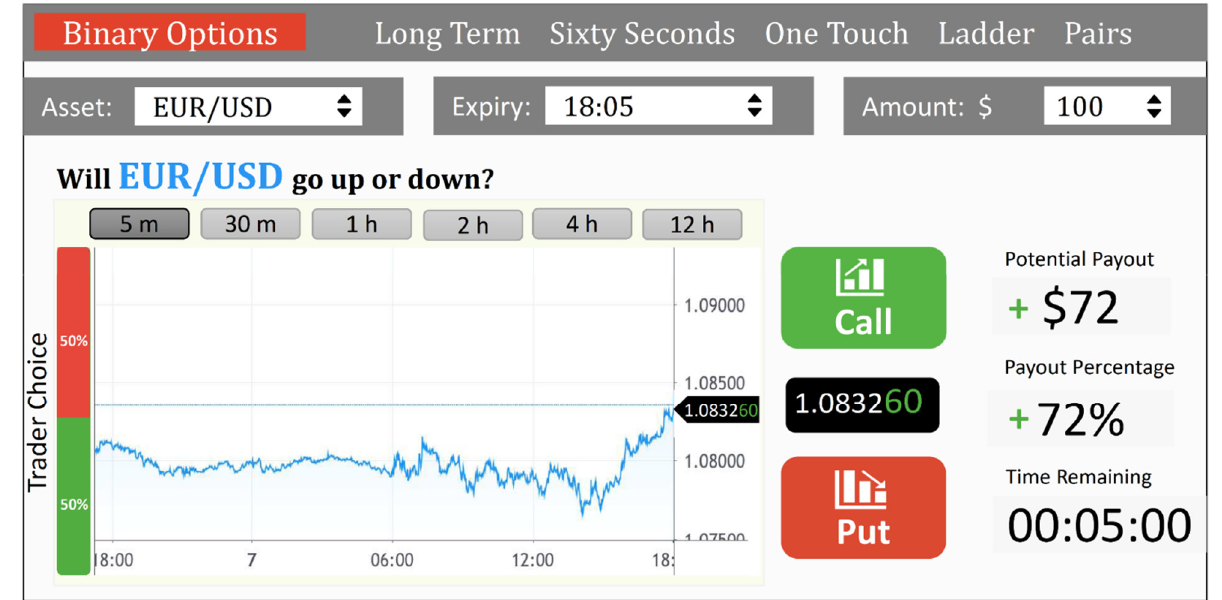
Figure 1. Typical user interface for binary options trading.